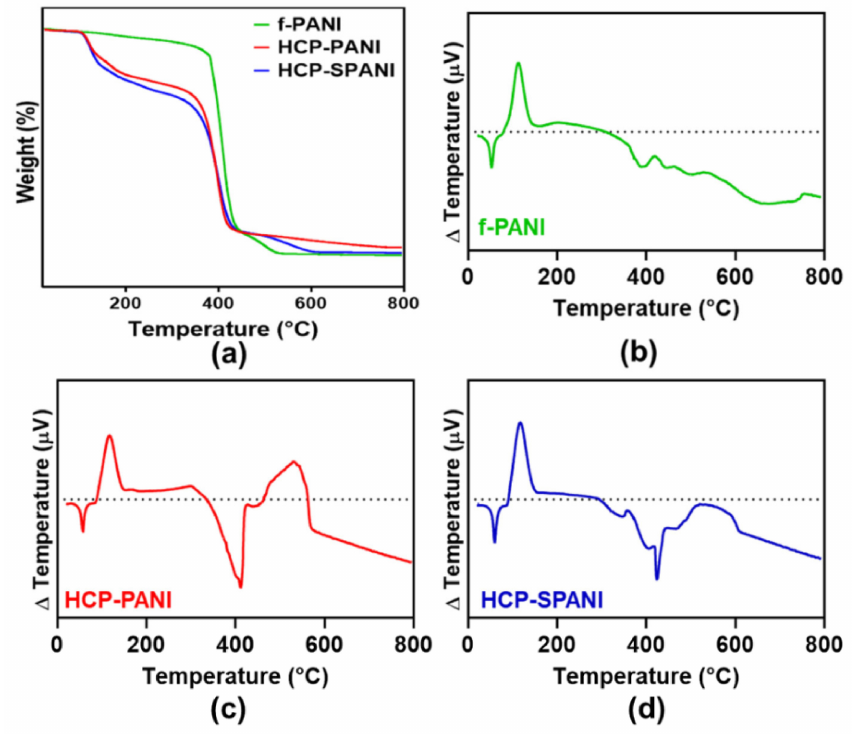
Figure 5. Characterization of fabricated films. ( a ) TGA and ( b – d ) DTA analysis of the f-PANI, HCP-PANI, and HCP-SPANI